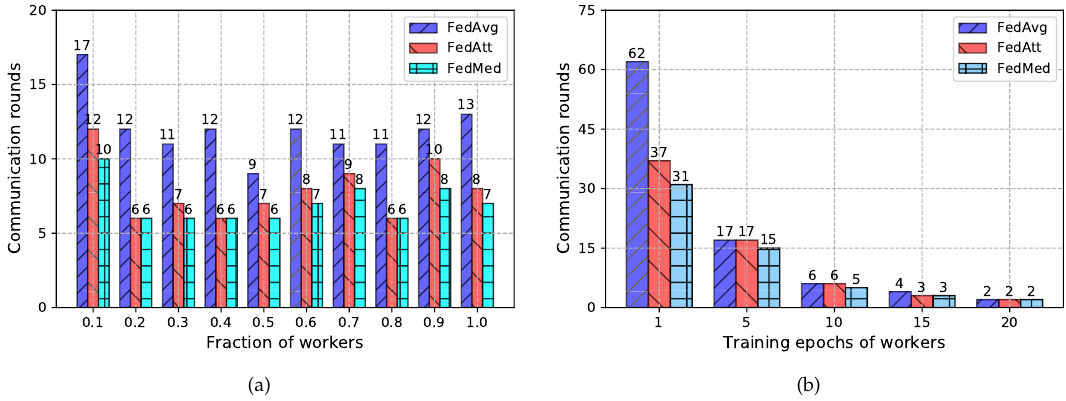
Figure 6. Experimental results of communication rounds with three different methods on WikiText-2 dataset on two factors. ( a ) Communication rounds consumed to achieve the preset performance level through different fractions of workers. ( b ) Communication rounds consumed to achieve the preset performance level through different epochs of workers during